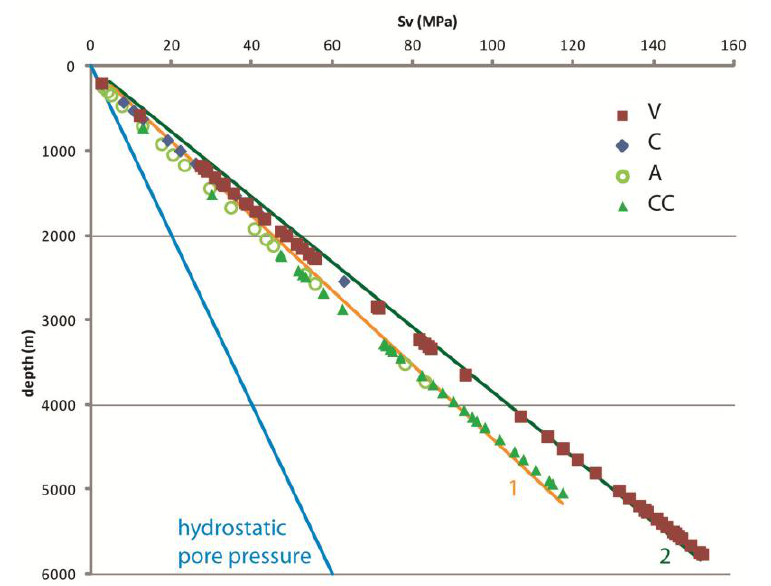
Figure 4 . Vertical stress (Sv) estimated from sonic log data. 1, trend line of data from the wells in the foredeep (A and CC); 2, is relative to the wells in the Apennine belt (V and C).